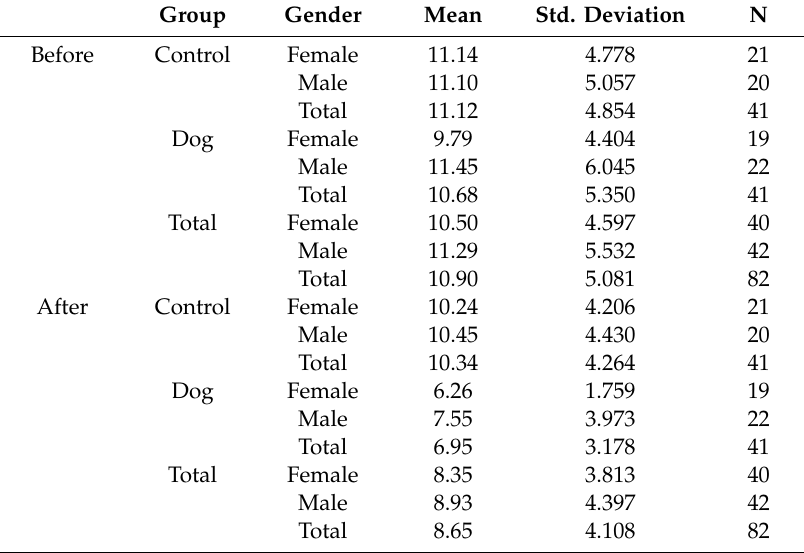
Table 8. Descriptive Statistics: Sadness and Gender.